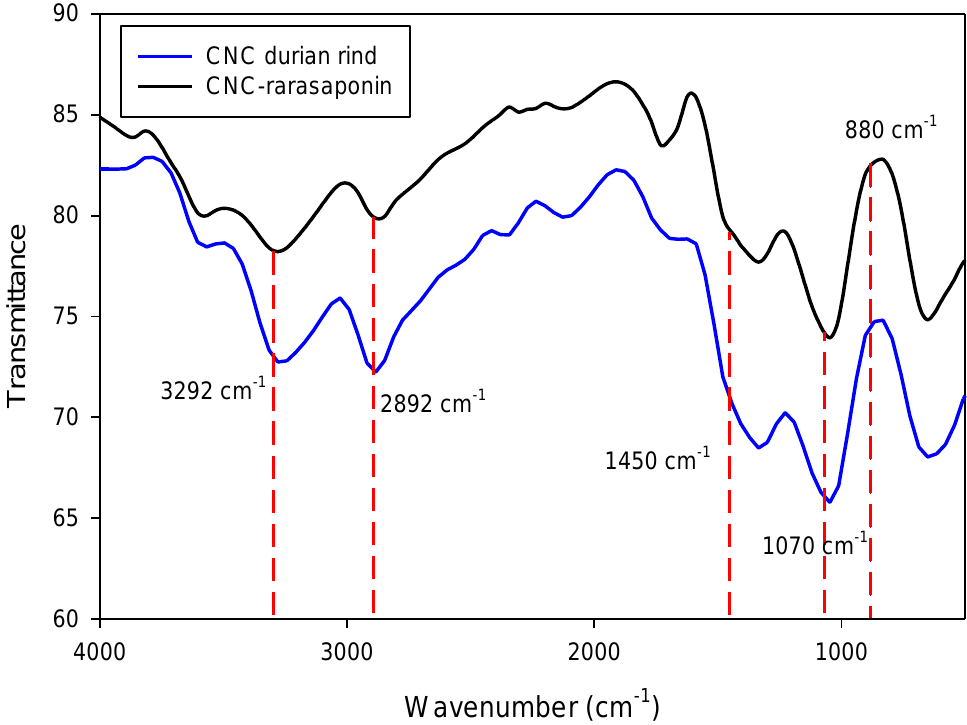
Figure 5. FTIR spectra of durian rind CNCs and CNCs-rarasaponin.